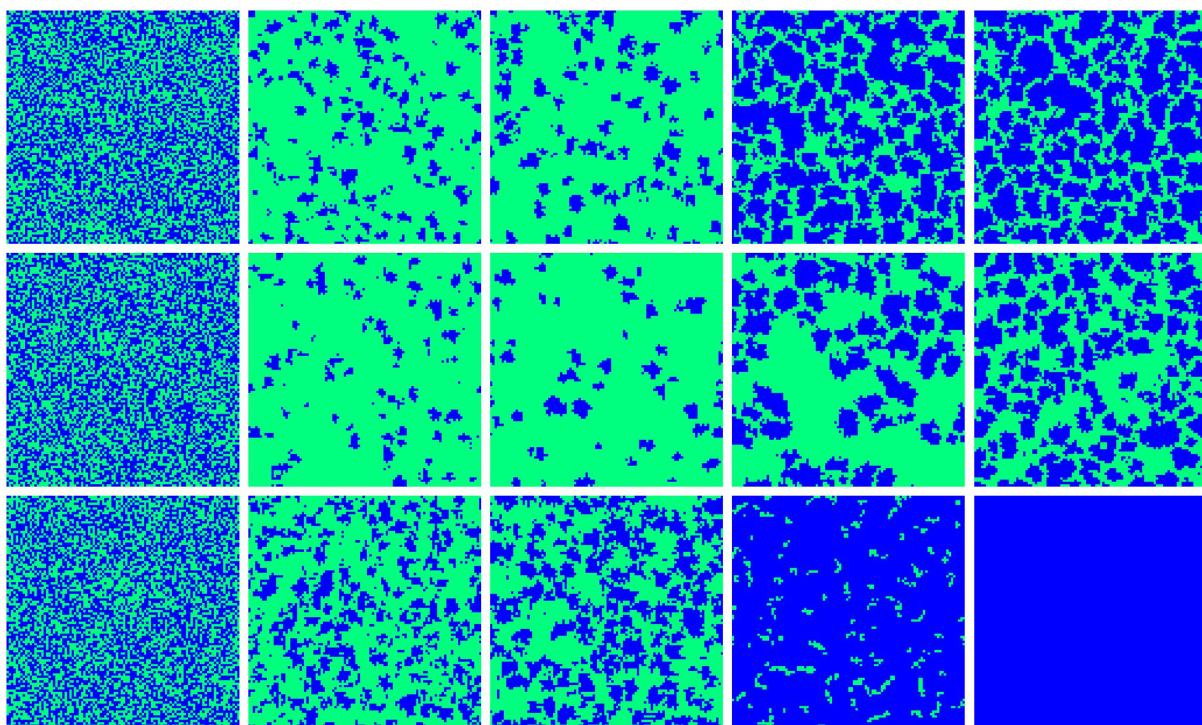
Fig 3. Typical strategy distribution of cooperators (blue) and defectors (green). The snapshots are given for t = 0, 5, 10, 100, 10000. The top panels are the traditional version. The middle panels and the bottom panels are the situations for α = − 0.2 and α = 1. The depicted results are obtained for M = 1, K = 0.5 and r =